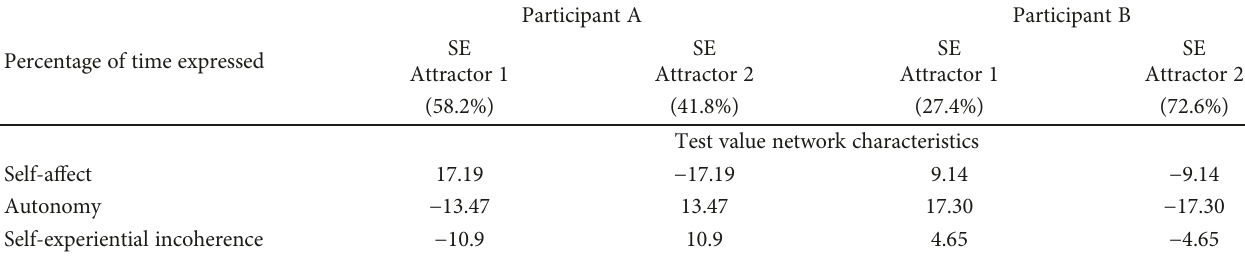
Table 1: Examples of self-esteem attractor characterizations for two participants (A and